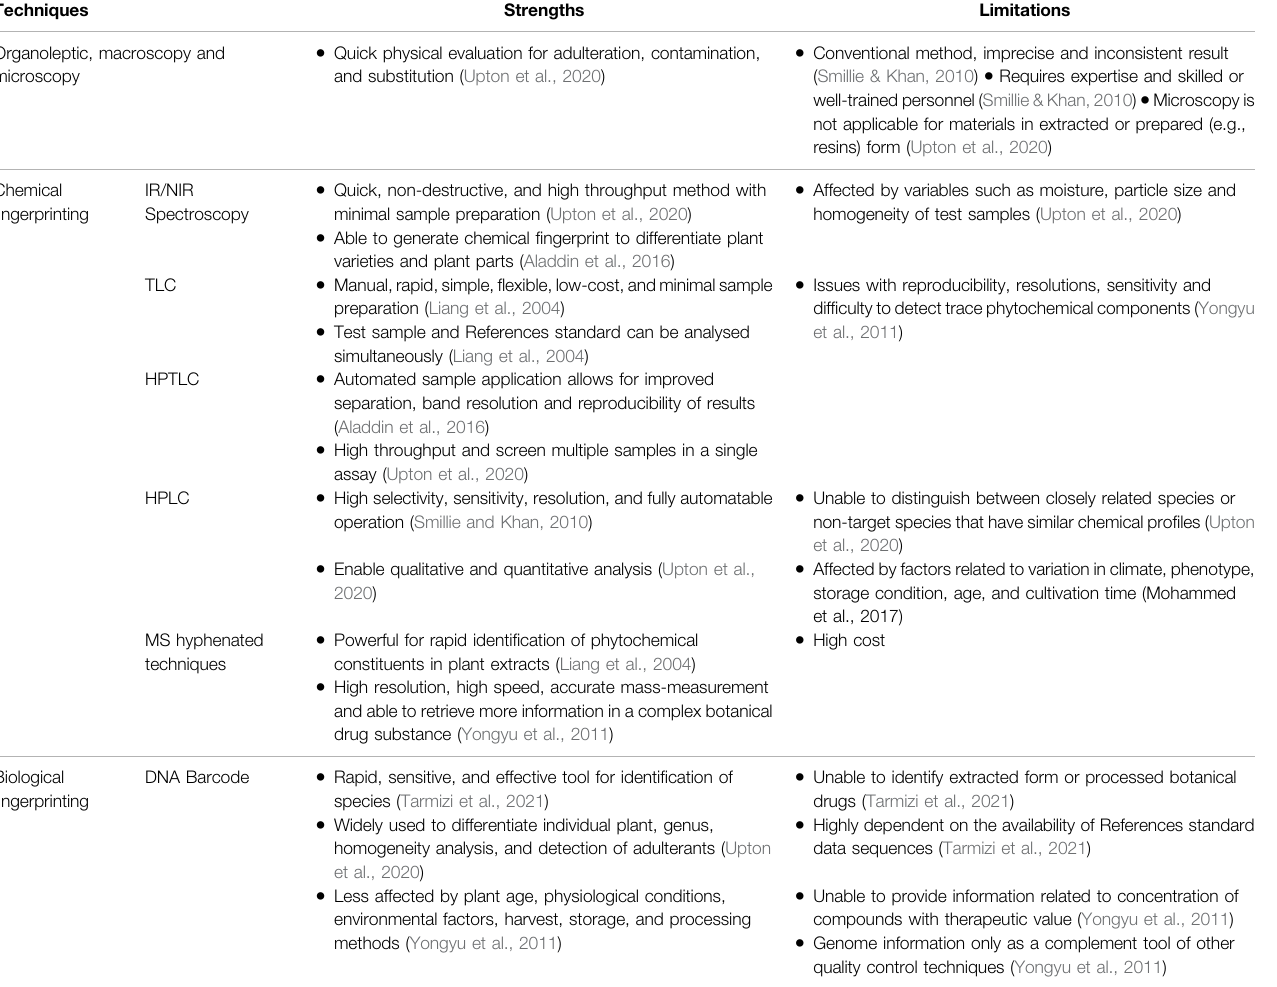
TABLE 3 | Strengths and limitations of analytical techniques for Marantodes pumilum authentication.